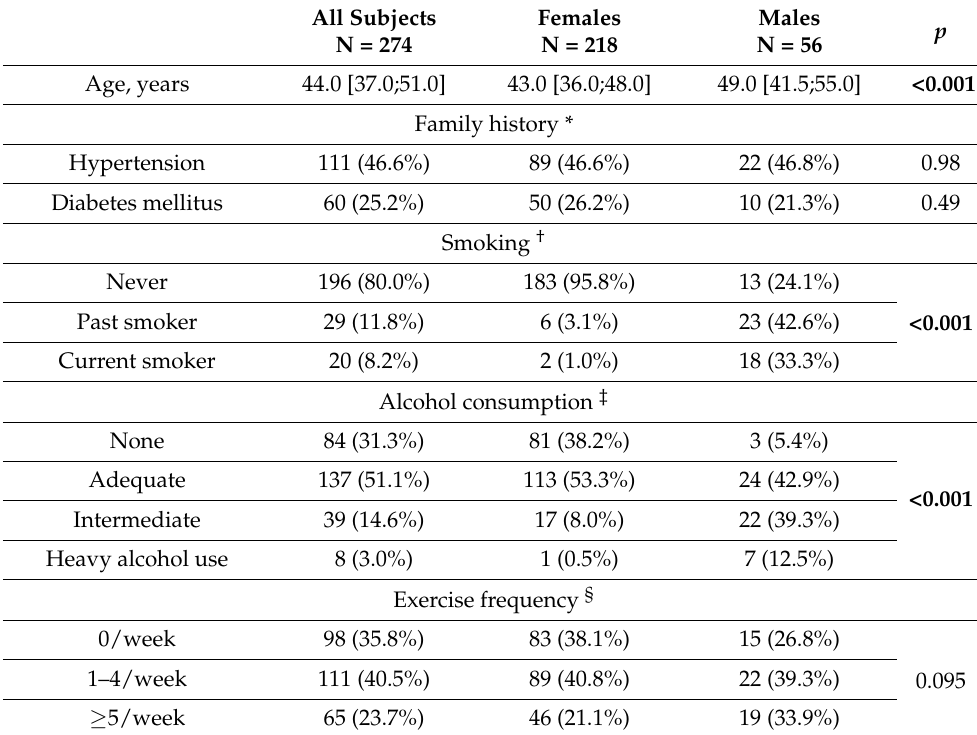
Table 1. Characteristics of the study